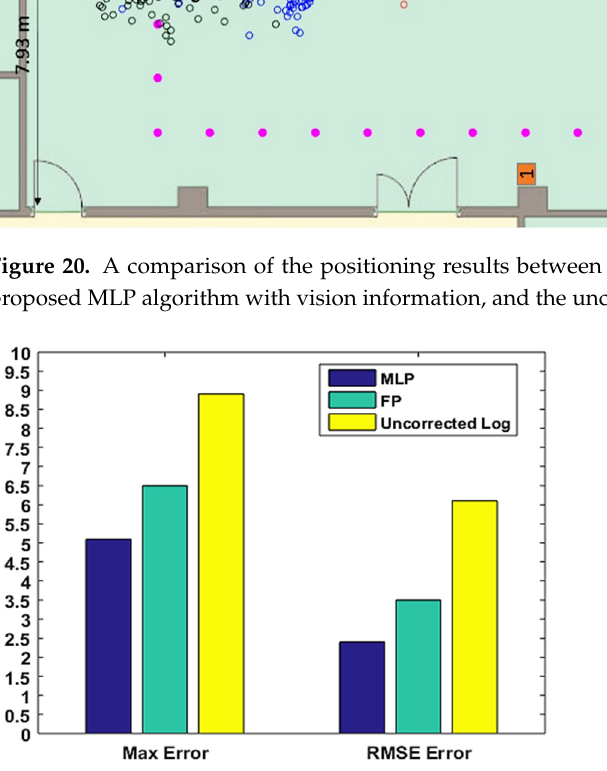
Figure 20. A comparison of the positioning results between the fingerprinting (FP) method, the pro- posed MLP algorithm with vision information, and the uncorrected log-normal method.